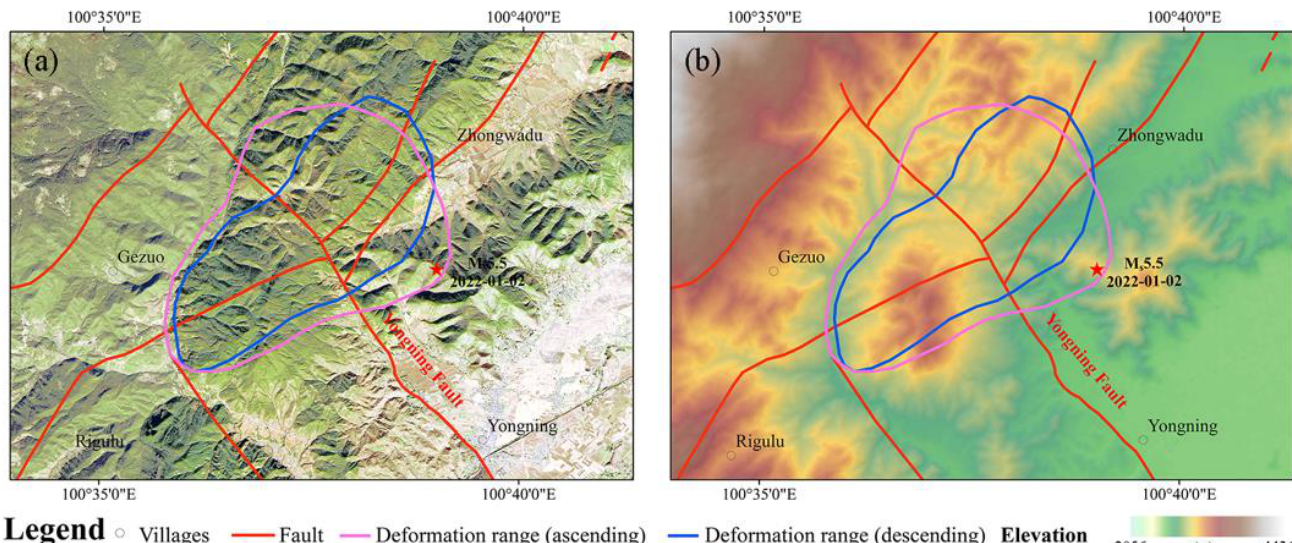
Figure 12. ( a ) the ZY-1 02D remote sensing image superimposed deformation range; ( b ) the DEM superimposed deformation range; The red star is the location of the epicenter given by the CENC. For a purely positive fault-type earthquake, the sinking deformation zone in the co- seismic field should be located in the upper wall (northeast side in this region) of the nor- mal fault, while the uplifting deformation zone should be located in the lower wall (south- west side) of the normal fault [84]. The uplift coseismic field acquired by InSAR is con- sistent with this property, i.e., the upper wall (northeast side) exhibits LOS to subsidence motion, the lower wall (southwest side) exhibits LOS to uplift motion, and the defor- mation volume of the upper wall is larger than that of the lower wall. However, the char- acteristics of the deformation field obtained by InSAR are not fully consistent with those of positive fault earthquakes; meanwhile, the lower wall (southwest side) shows LOS di- rectional subsidence motion, so it is assumed that the Ninglang earthquake is dominated by positive fault and right-slip motion. During the relative motion of the upper wall de- scending on the orthotropic fault, the two walls will move in opposite directions of